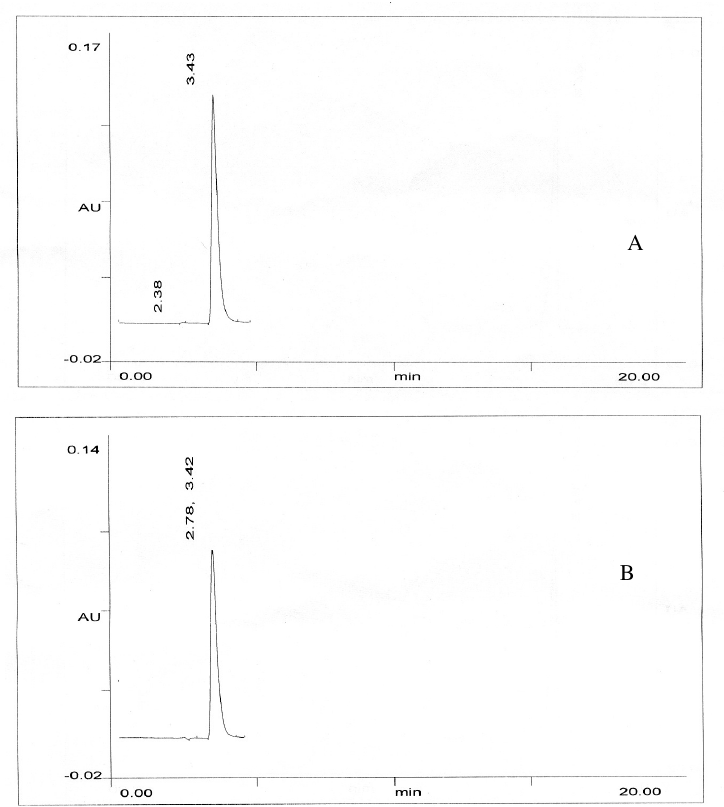
Figure 6 . (A) Chromatograms of venlafaxine hydrochloride standard solution (30 µ g/mL) and (B) Venlafaxine hydrochloride extracted from VENLOR XR-75 capsules.